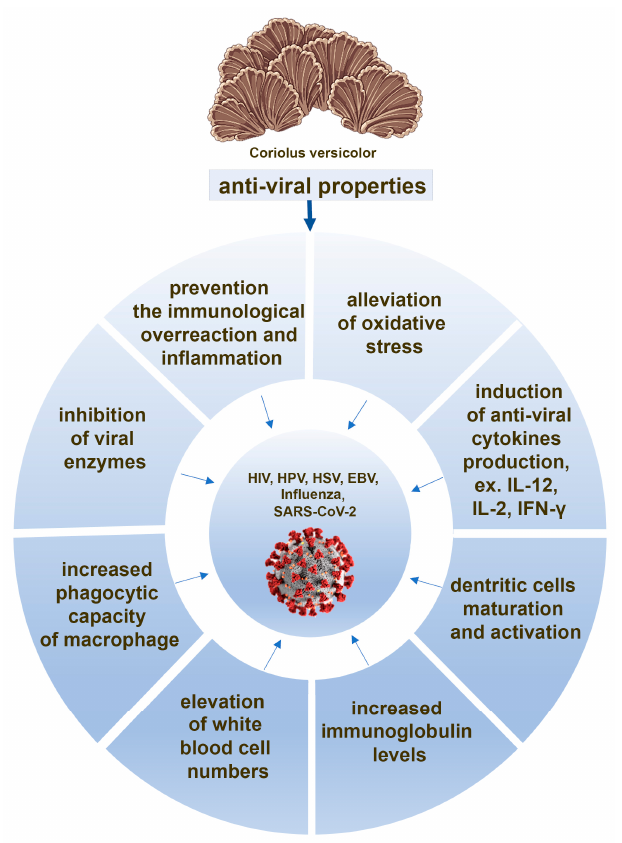
Figure 2. The potential anti-viral actions of the compounds derived from Coriolus versicolor mush- room.